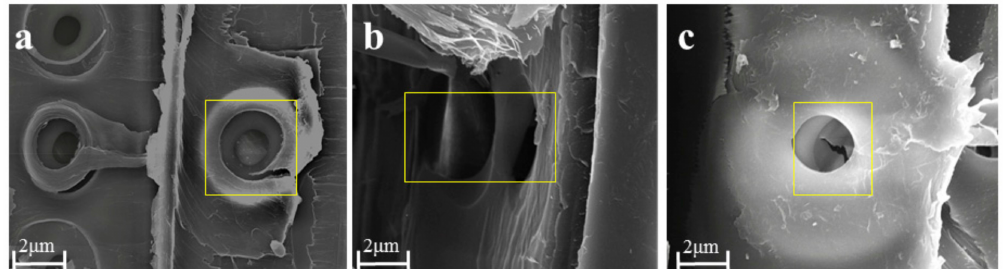
Figure 5. SEM images of RP: ( a ) untreated sample, ( b ) sodium bicarbonate-treated sample, ( c ) ozone-treated